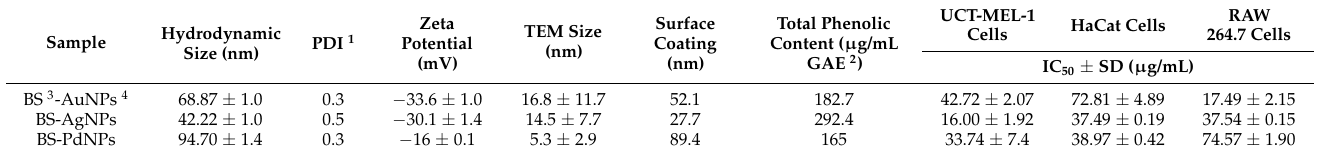
Table 2. Physiochemical data parameters and antiproliferative activity of synthesized